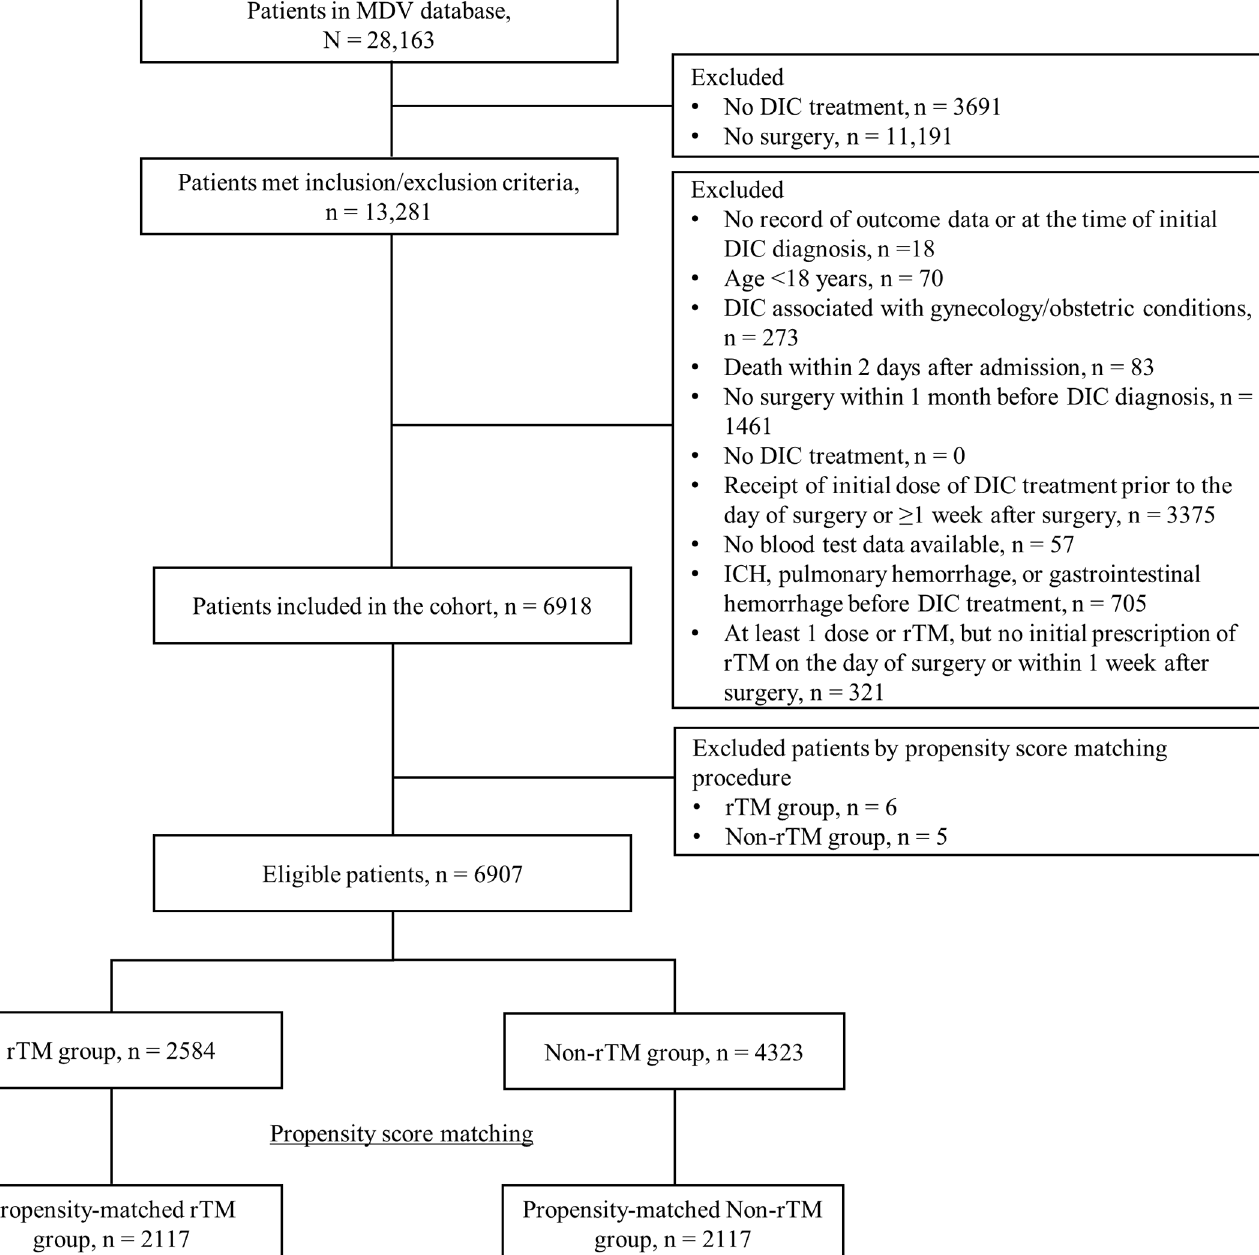
PLOS ONE | https://doi.org/10.1371/journal.pone.0205146 October 8,